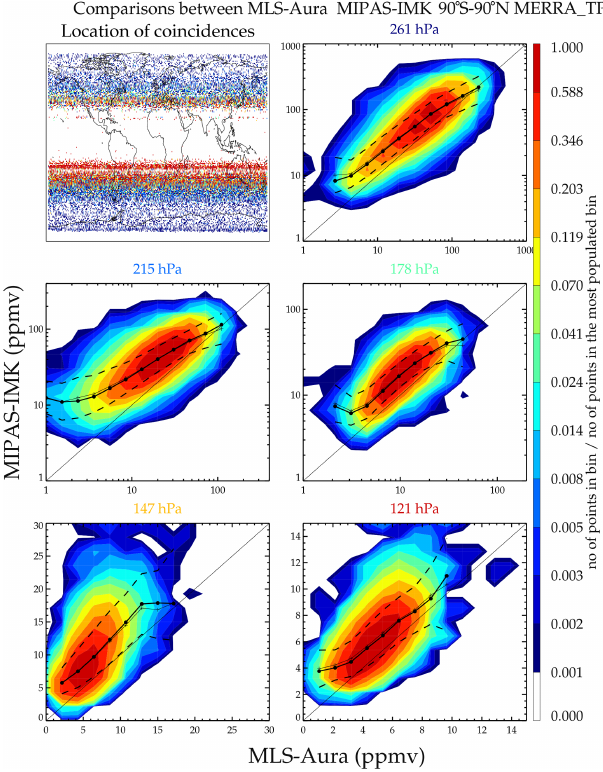
Figure 18. Same as Fig. 17 but comparing MLS-Aura and MIPAS- IMK. The coincidences cover a period from January 2005 to April